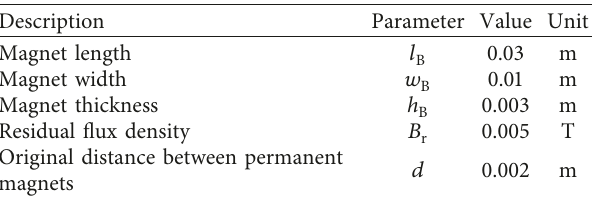
Figure 3: Geometric diagram between the two rectangular per- manent magnets at the relative position. Table 1: Dimensions of the magnets.